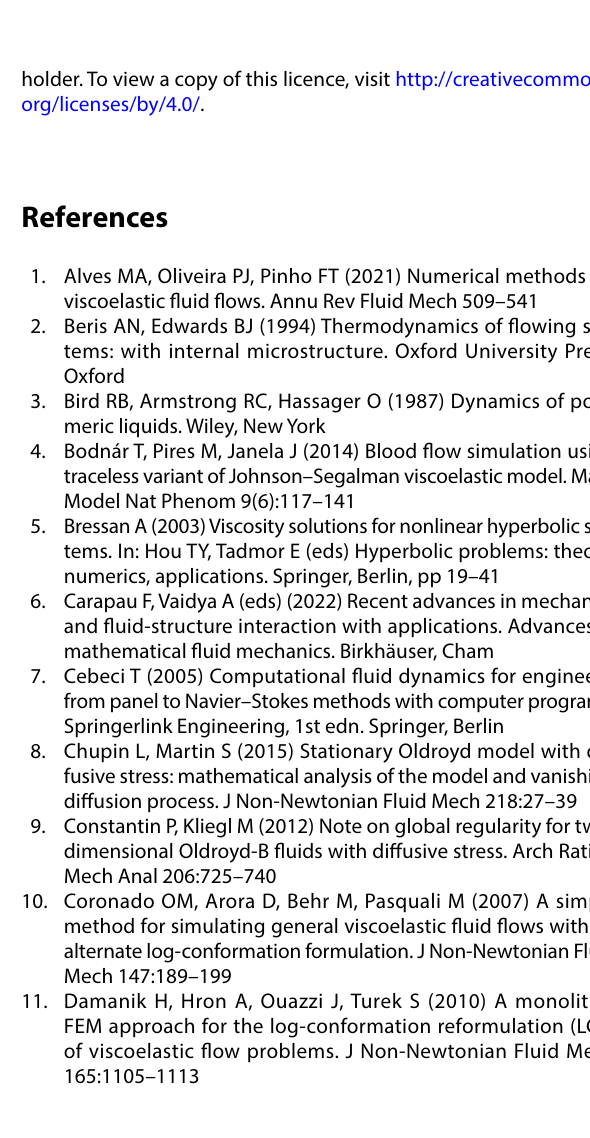
Fig. 21 Comparison of the maximum of the stress tension on the wall for diffusion coefficient 𝛼 ( Weissenberg numbers W e for different lengths of the averaging history L